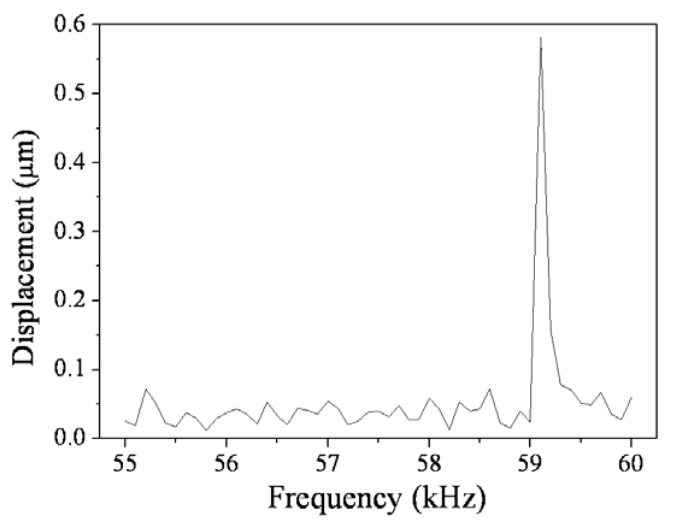
Figure 10. Frequency response of the